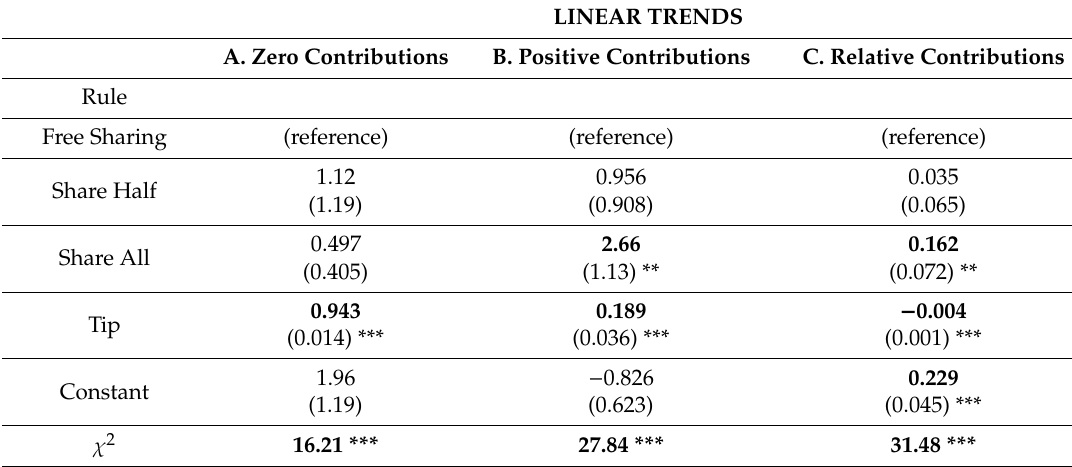
Table A1. Linear regressions. A. Proportion of waiters’ zero contributions for di ff erent tip amounts. B. Waiters’ absolute positive contributions for di ff erent tip amounts. C. Waiters’ relative positive contributions for di ff erent tip amounts.